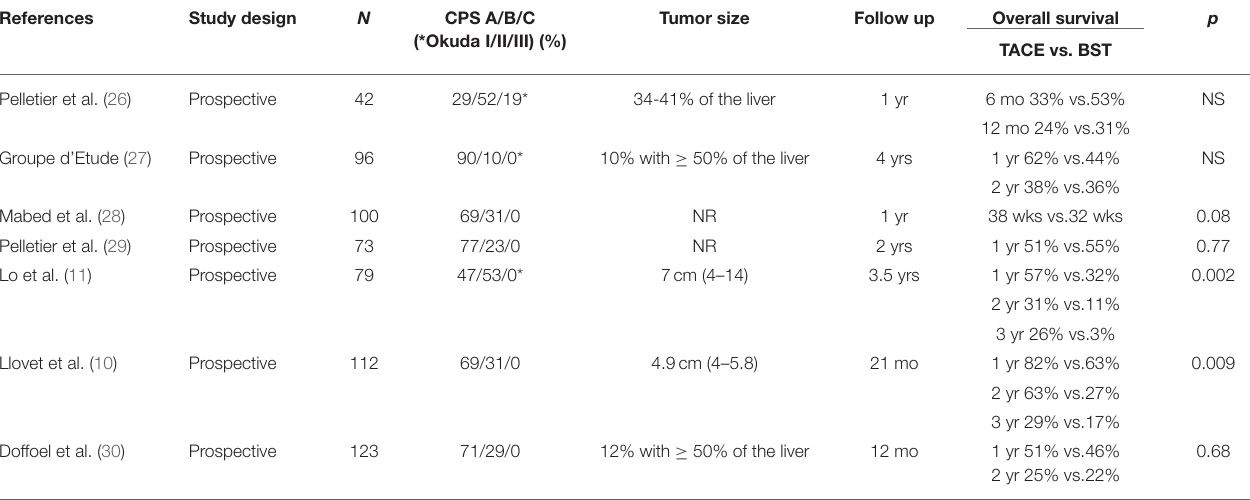
TABLE 2 | Studies of transcatheter arterial chemoembolization vs. best supportive treatment for hepatocellular carcinoma.